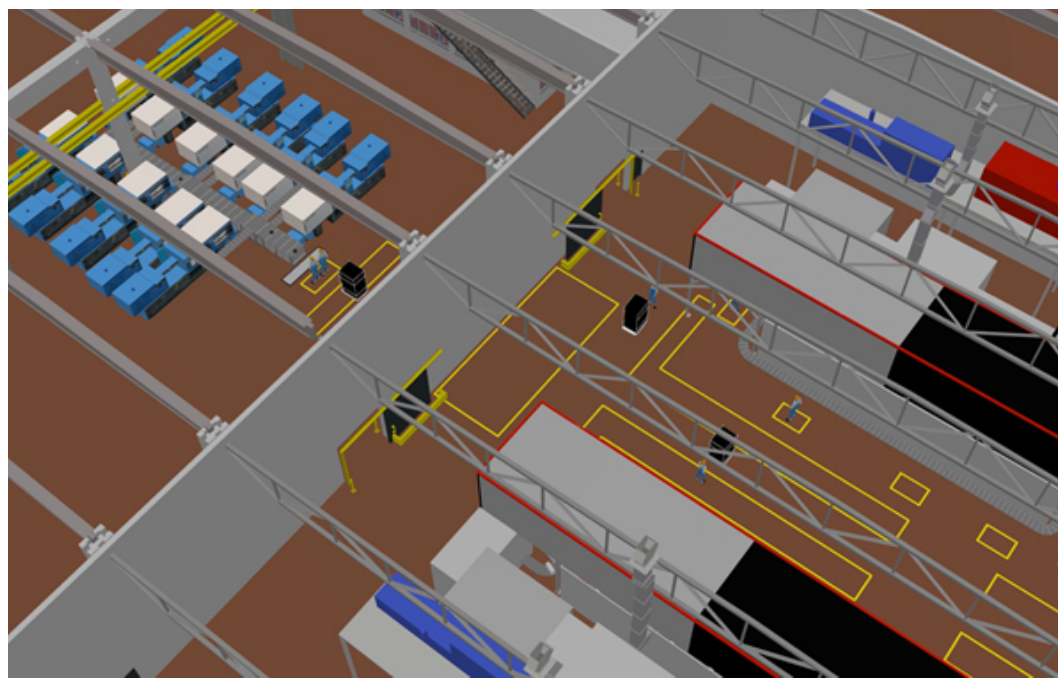
Figure 2. Production flow of the application case in AnyLogic